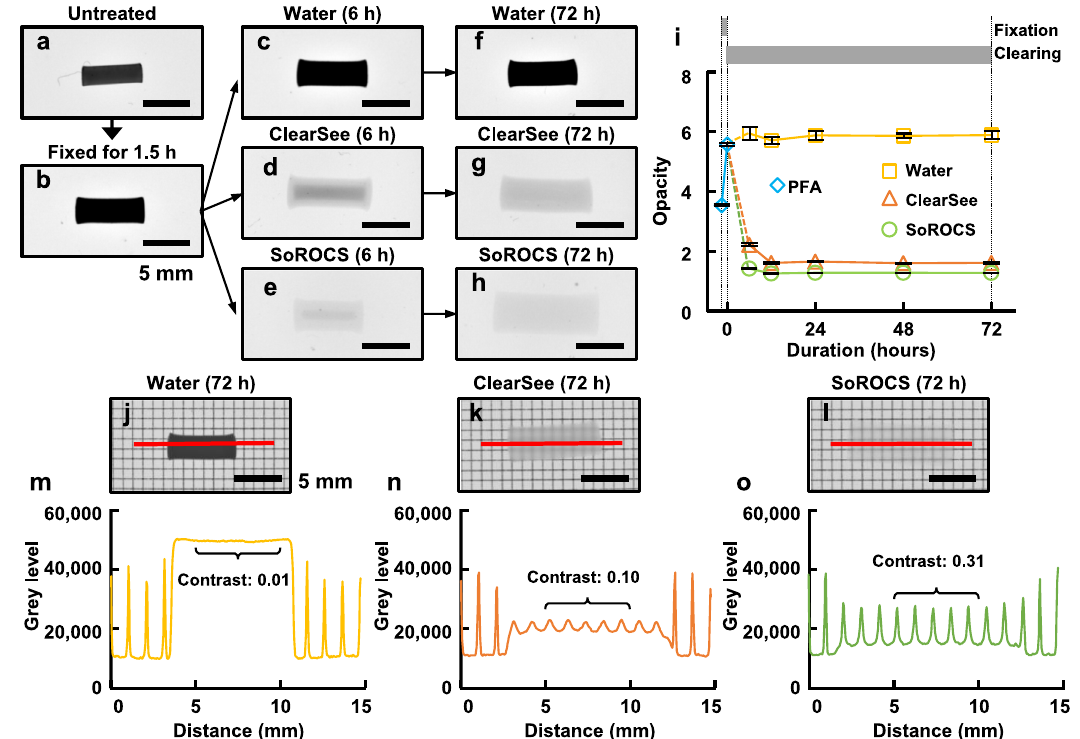
Fig. 1 Optical clearing performance of SoROCS. a – h , j – l Photographs were obtained using ImageQuant for transmission. Note, none of the samples were the same and they were prepared separately ( a – h ); however, the images presented in ( j – l ) are the same samples as in ( f – h ), respectively, with a grid pattern-printed fi lm as a background. Scale bars indicate 5 mm ( a – h , j – l ). Untreated noodle sample ( a ) was fi xed with 4% PFA/PBS for 1.5 h ( b ) and immersed in water (0.5% (wt wt − 1 ) sodium azide added to prevent spoilage) ( c , f ), ClearSee ( d , g ) or SoROCS ( e , h ). i Opacity curves in the fi xation process (light blue) and clearing process using water (yellow), ClearSee (orange) or SoROCS (green) were calculated from the transmission images of noodles without the grid pattern-printed fi lm. Data are presented as mean values ± SD ( N = 3 independently prepared noodle samples). Plot pro fi le for the noodle treated with water ( m ), ClearSee ( n ) or SoROCS ( o ). The red line in ( j – l ) indicates the corresponding location of the plot pro fi le in ( m – o ), respectively. The contrast value in the plot pro fi le for the areas shown in curly brackets is shown in ( m – o ), respectively. Source data underlying ( i , m – o ) are provided as a Source Data fi